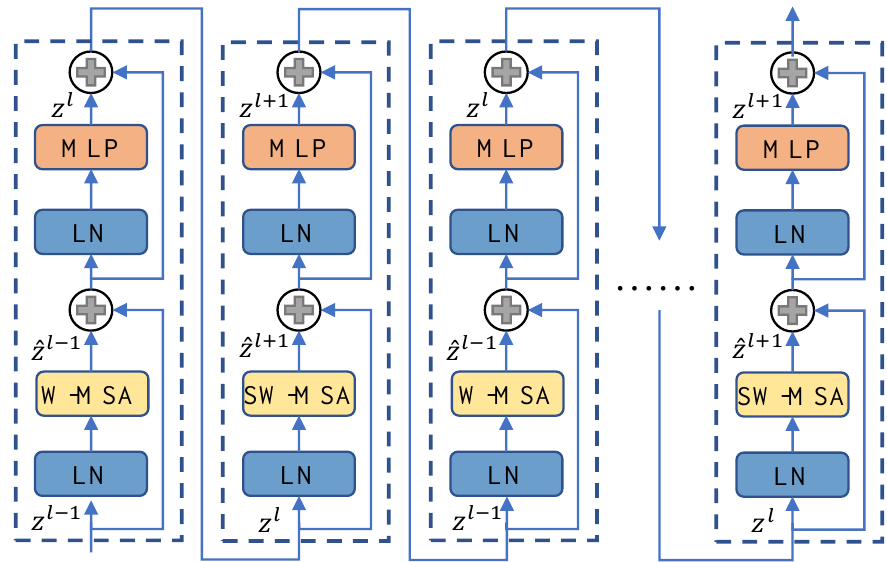
Figure 3. The internal structure of the swin Transformer